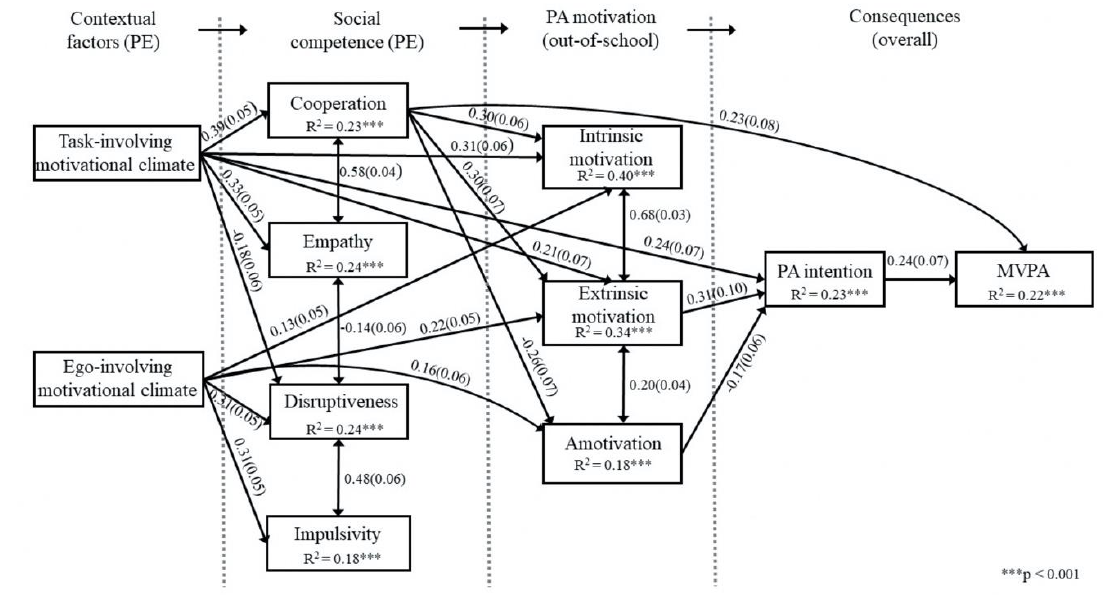
Figure 1. Standardized parameter estimates for hypothesized model. All paths are significant at p < 0.05 level.